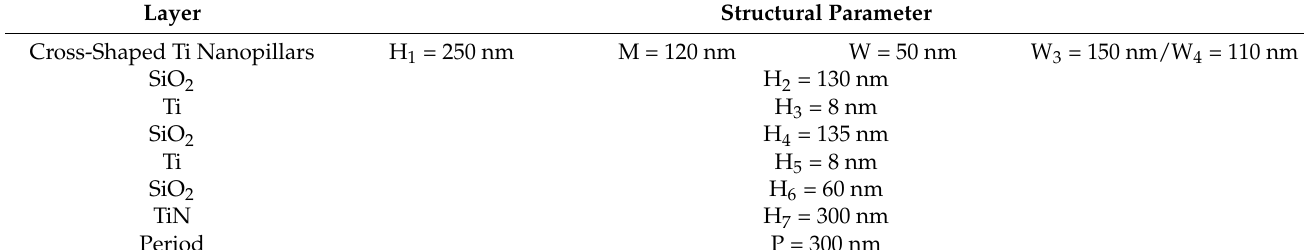
Table 1. The structural parameters used in the simulation.